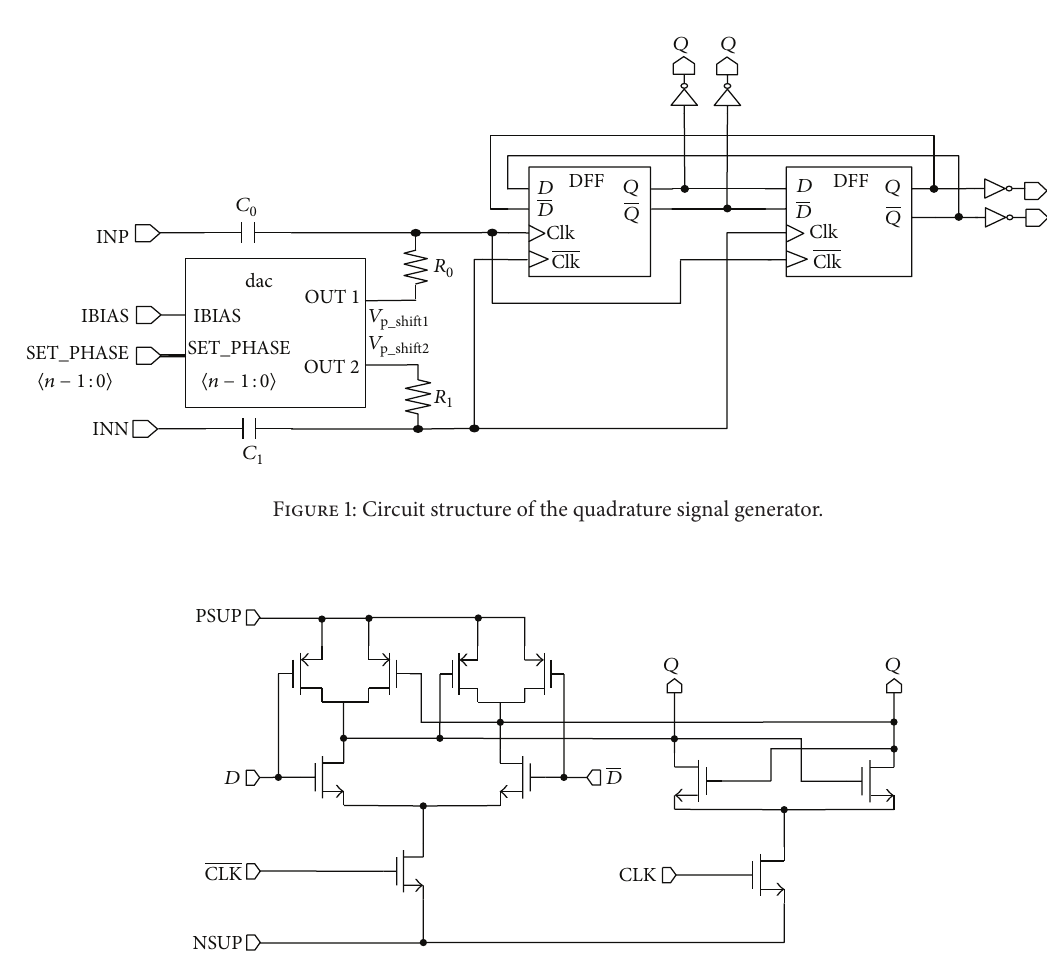
Figure 2: Circuit structure of D flip-flop